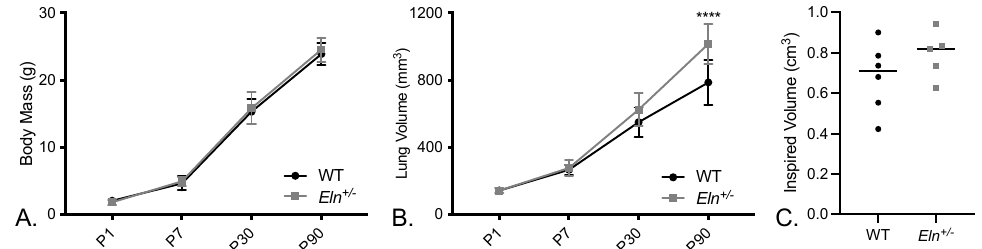
Figure 2. Eln +/ − mice lungs are larger when assessed ex vivo, but not in vivo. ( A ) Body mass with age. ( B ) Ex vivo lung volumes. ( C ) Inspired lung volume as measured by in vivo CT at ~90 days of age. ( A , B ) were analyzed using two-way ANOVA with multiple corrections in ( B ) done by Šídák’s multiple comparison test. ( A ) 2-way ANOVA p < 0.0001 for age and p = NS for Eln genotype. ( B ) 2-way ANOVA, age effect p < 0.0001, Eln genotype effect p < 0.0001. **** p < 0.0001. ( C ) was assessed by a Mann–Whitney test (WT 0.6797 ± 0.1703 vs. Eln +/ − 0.7896 ± 0.1173, p = NS).